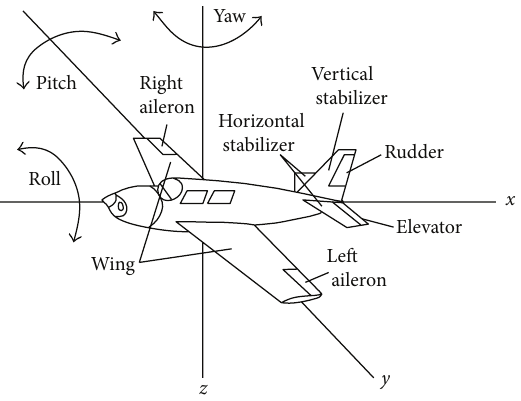
Figure 1: Control surfaces in